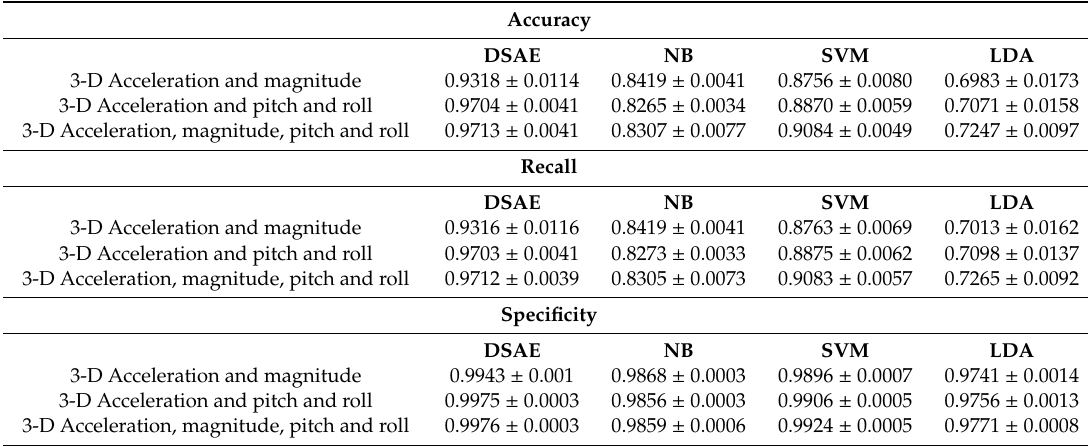
Table 5. Performance results for fusion of di ff erent data